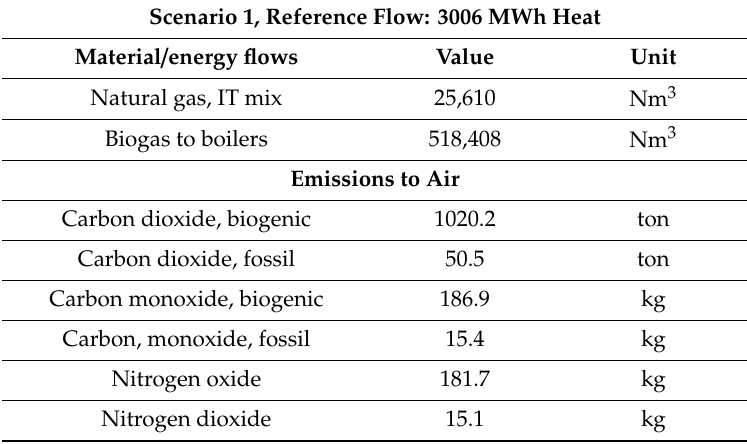
Table 9. The operational phase of the boilers (primary data from data collection at the WWTP